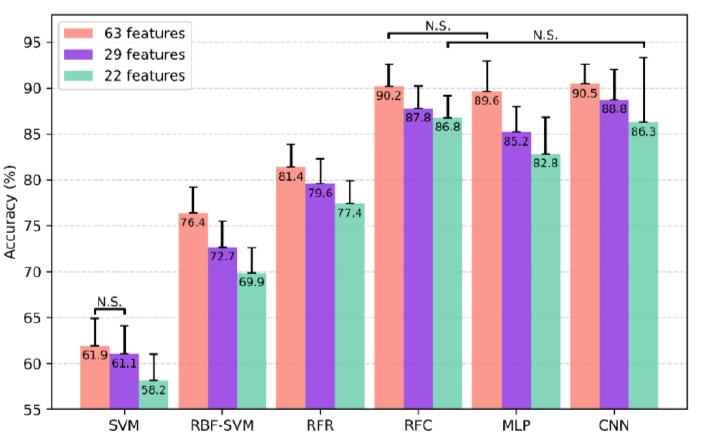
Figure 3. Various models’ classification accuracy with standard deviation. Pairs that did not differ significantly are marked N.S. (non-significant).